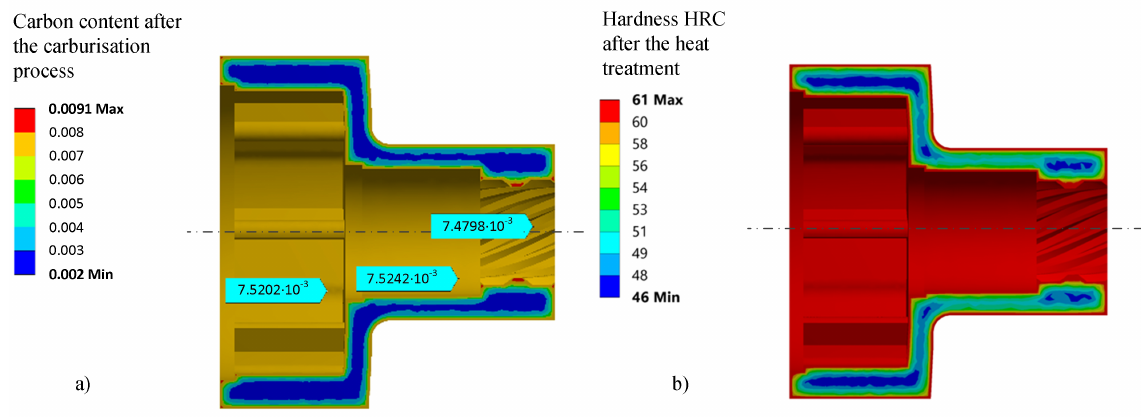
Figure 5. ( a ) Carbon content distribution over the cross-section of the starter clutch barrel after the carburisation. ( b ) Hard- ness distribution over the cross-section of the starter clutch barrel after the heat treatment. Radial, tangential and axial stresses after the heat treatment, at the time of operation and comparison with the non-heat-treated material are compared in Figures 6–8, respectively.